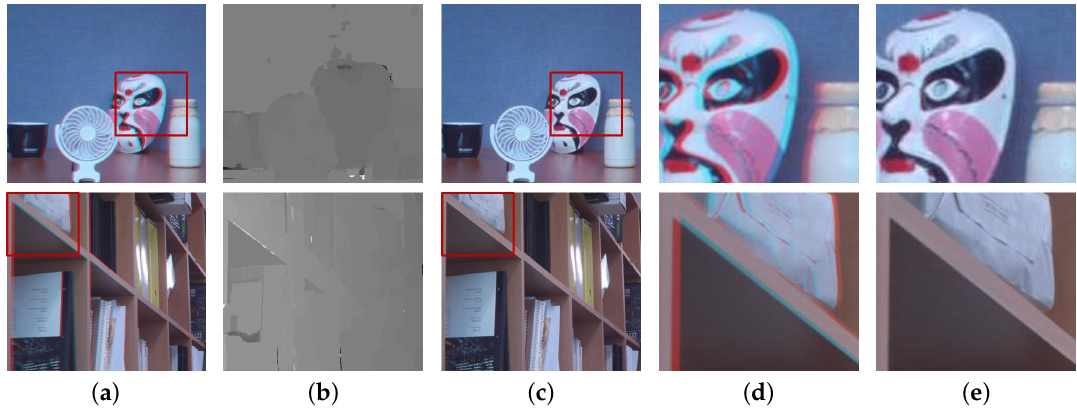
Figure 13. Proposed cross-channel disparity estimation and registration results. ( a ) Input images,